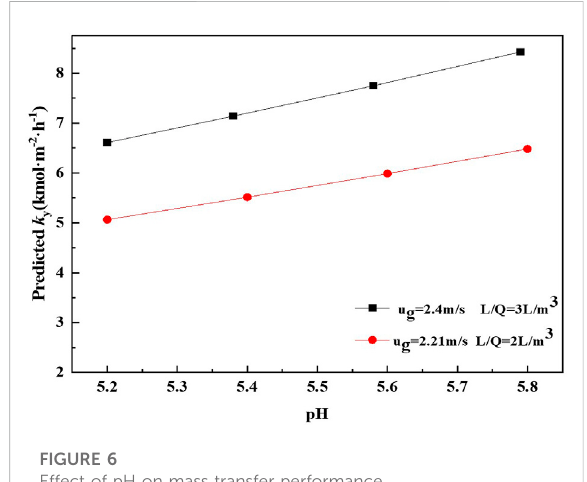
FIGURE 4 Effect of u g on mass transfer performance.